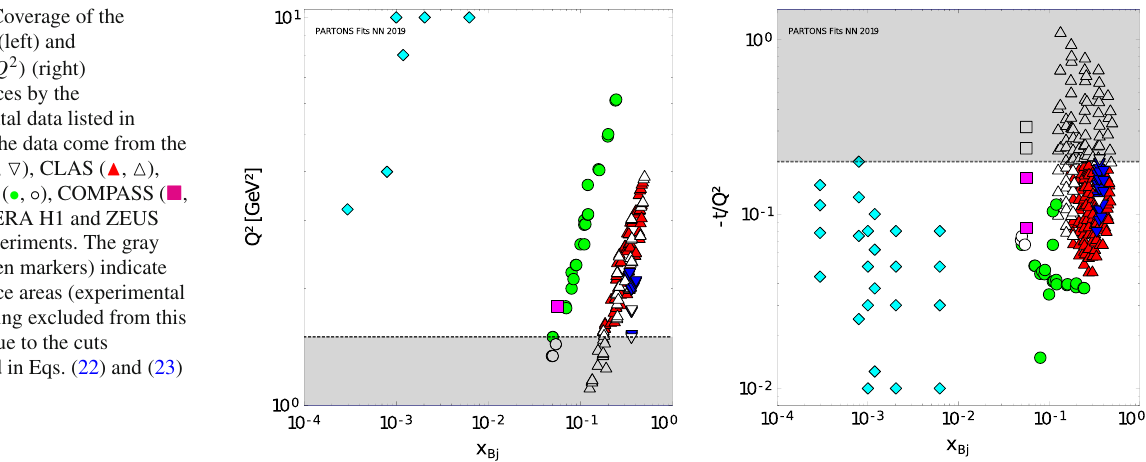
Table 3 Values of the χ 2 function per data set. For a given data set, cf . Table 2, given are: χ 2 value, the number of experimental points n , and the ratio between those two numbers No. Collab.